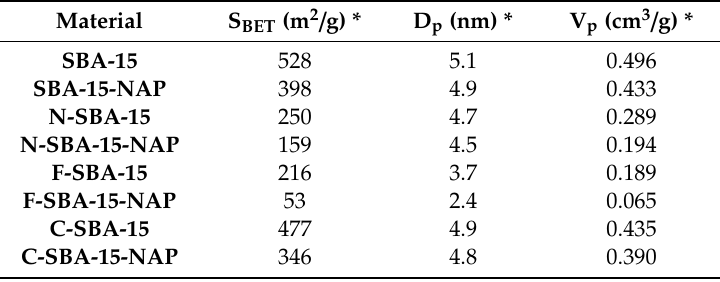
Table 1. Textural properties of the samples.